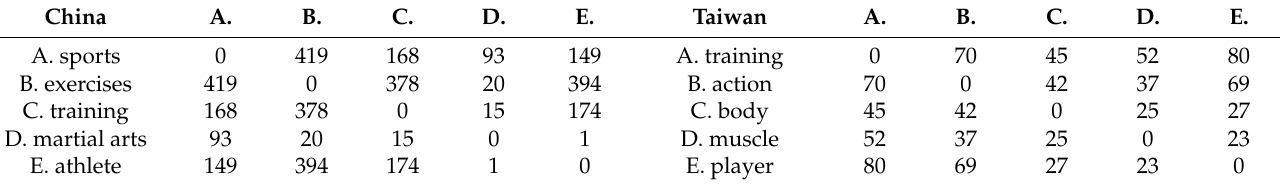
Table 4. Co-word matrix